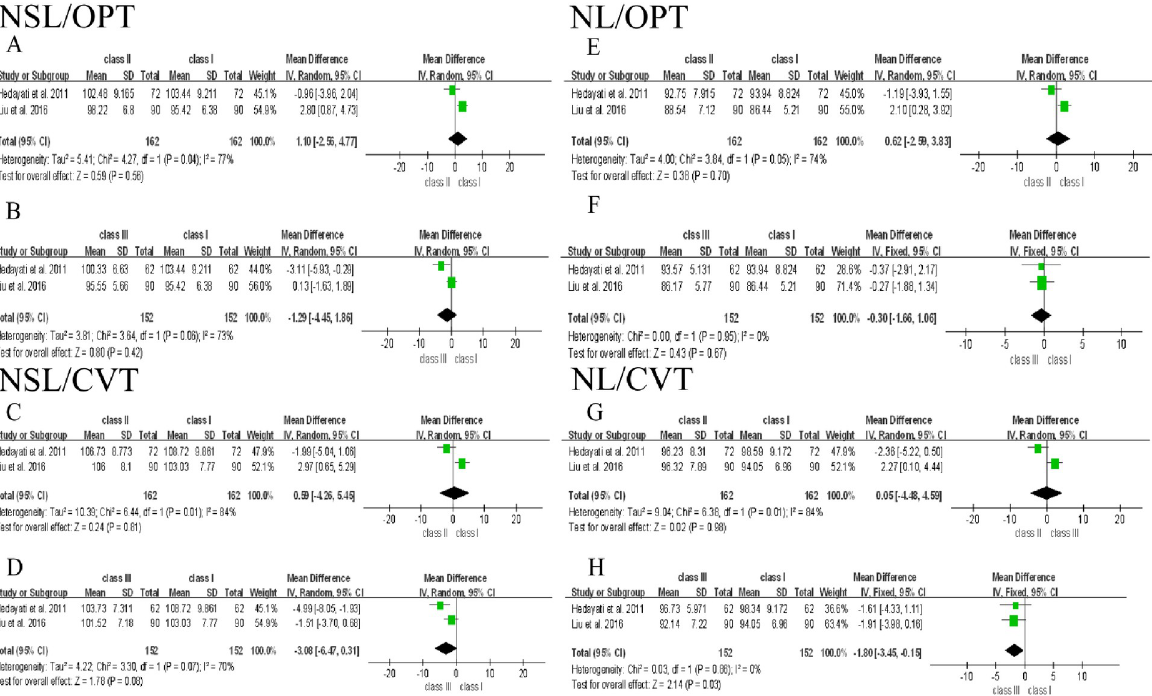
Fig 5. Forest plot of the association between craniocervical posture and Class I, II, and III malocclusion.